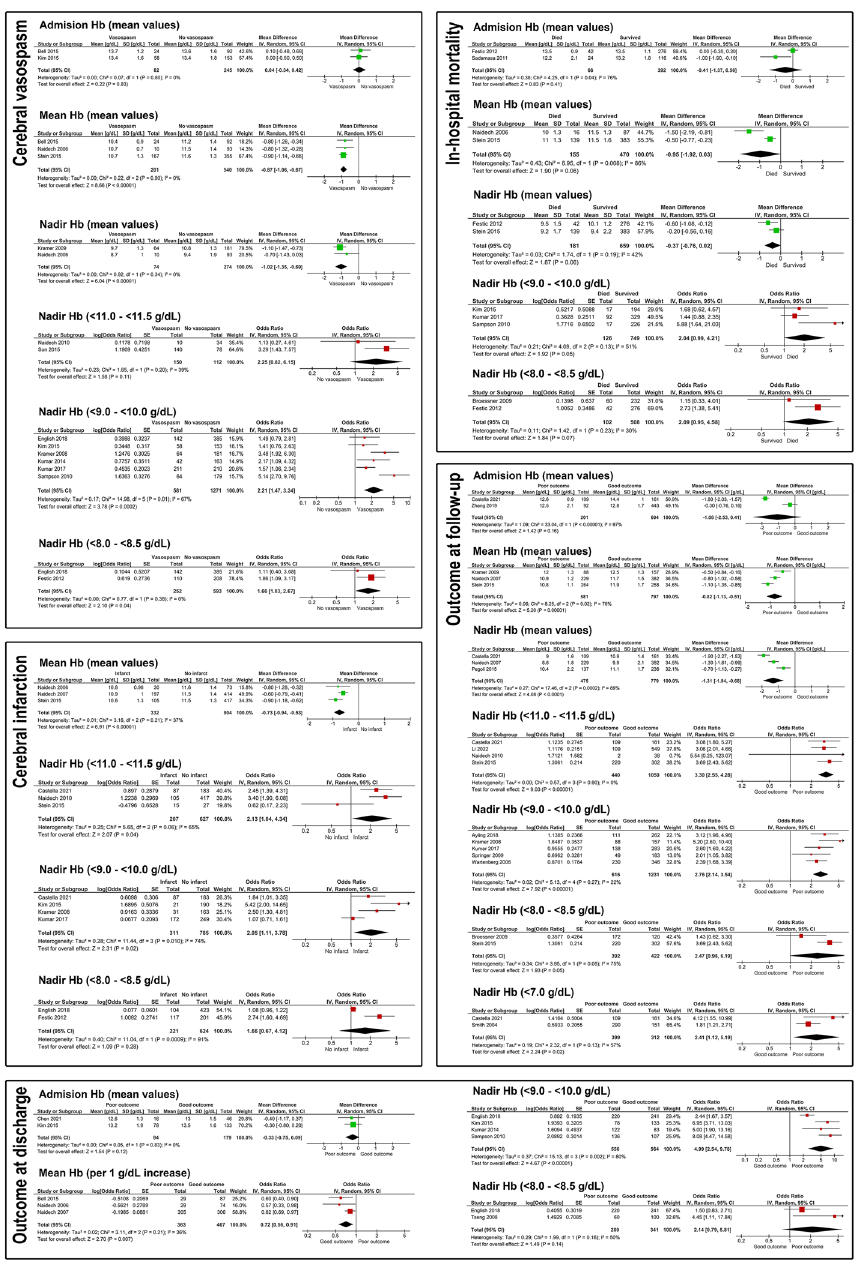
Figure 2. Forest plots analyses for the association between the severity of post-SAH anemia and selected primary endpoints: cerebral vasospasm, cerebral infarction, in-hospital mortality, poor outcome at discharge and at